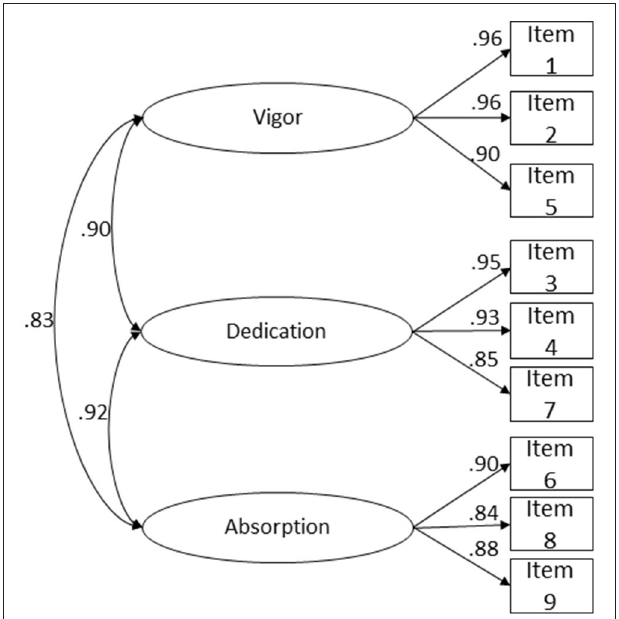
FIGURE 1 | UWES-9 tri-factor structure fit to a combined sample of Portuguese ( n = 520) and Brazilian Workers ( n = 524). Correlations between latent variables, and factor loadings for each item are shown χ 2 (24) = 408.520, p < 0.001, N = 1,046, CFI = 0.998, NFI = 0.998, TLI = 0.997, RMSEA =